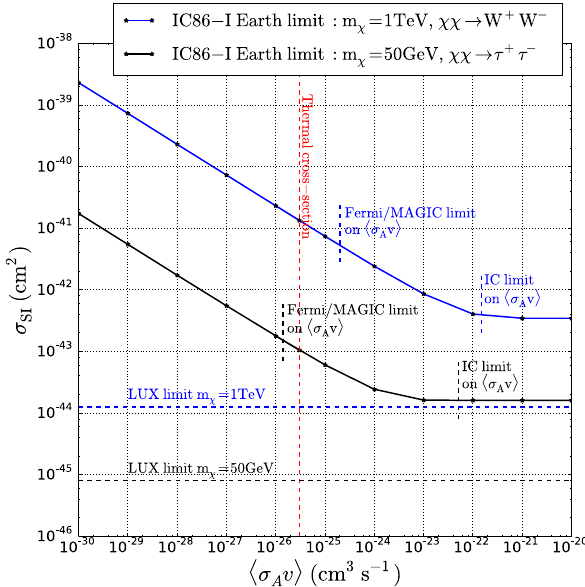
Fig. 29 Upper limits at 90% confidence level on σ SI Fig. 28 Upper limits at 90% confidence level on σ SI as a func- WIMP + N of the velocity-averaged annihilation cross section (cid:11) σ A v (cid:8) for 50 GeV tion of the WIMP-mass obtained from a dedicated Earth search with WIMPs annihilating into τ + τ − and for 1 TeV WIMPs annihilating IceCube-79 [252], assuming a WIMP annihilation cross section of (cid:11) σ v (cid:8) = 3 × 10 − 26 cm 3 s − 1 and a local dark matter density of 0.3 into W + W − . Limits from LUX [247] are shown as dashed lines for A comparison. The red vertical line indicates the thermal annihilation GeVcm − 3 .ResultsfromSuper-Kamiokande[253],SuperCDMS[254], cross section for a particle species to constitute the dark matter. Also LUX [247] and an IceCube-79 solar search [236] are shown for com- indicated are IceCube limits on the annihilation cross section for the parison. Figure from [252] respective masses and annihilation channels [255]. Figure from